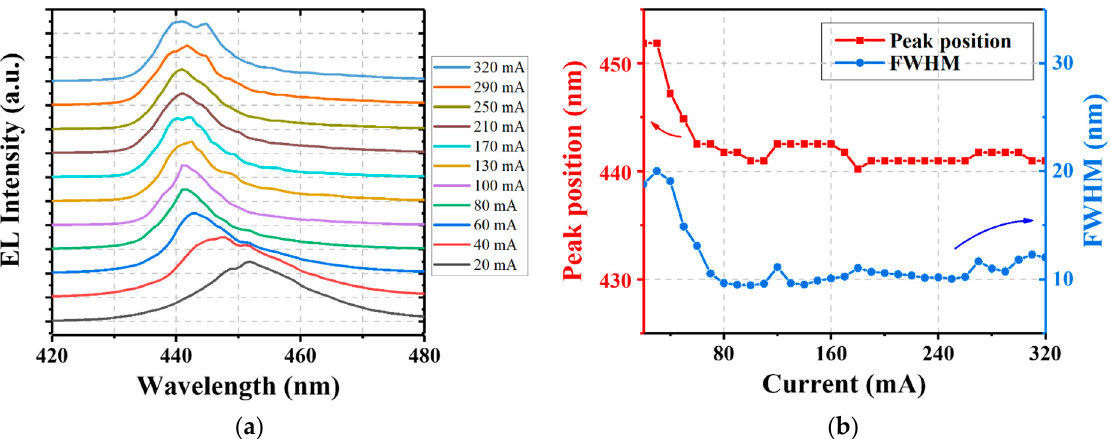
Figure 4. ( a ) Spectra of SLD under different injection currents ranging from 20 mA to 320 mA; ( b ) the changes in peak position and FWHM versus injection current.